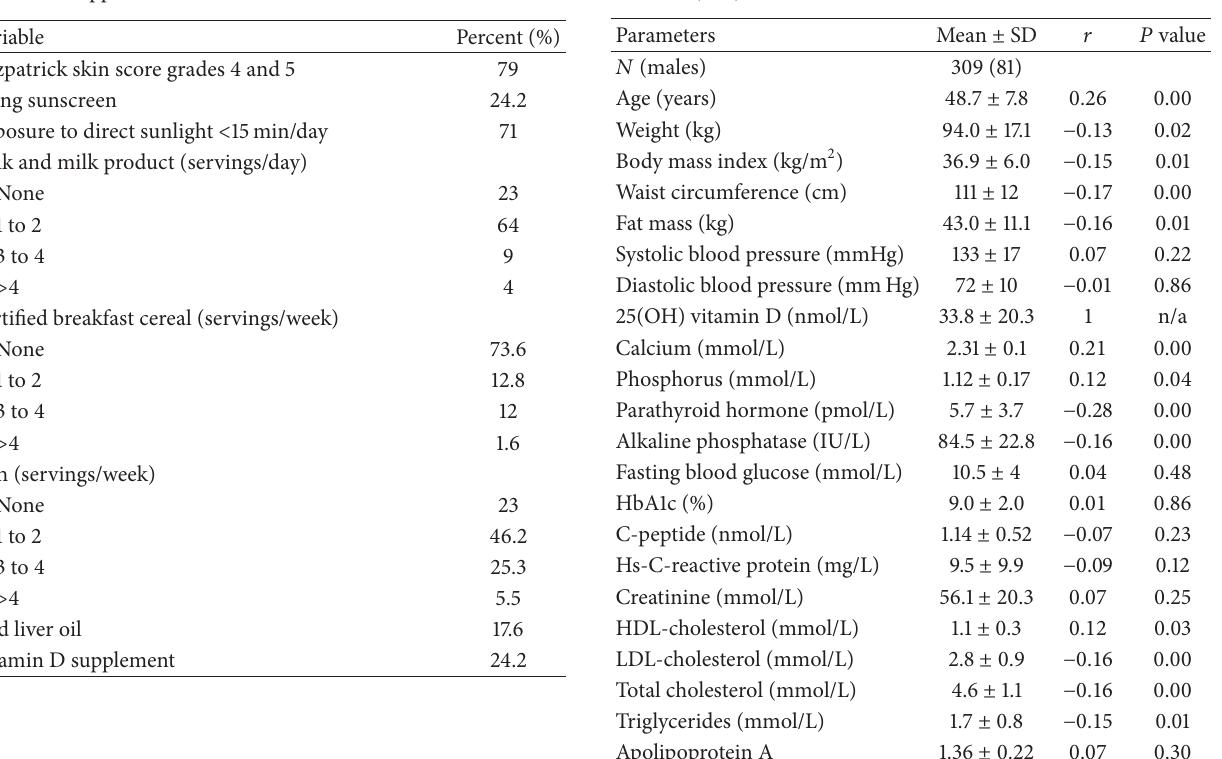
Table 2: Clinical characteristics of participants and correlation with serum